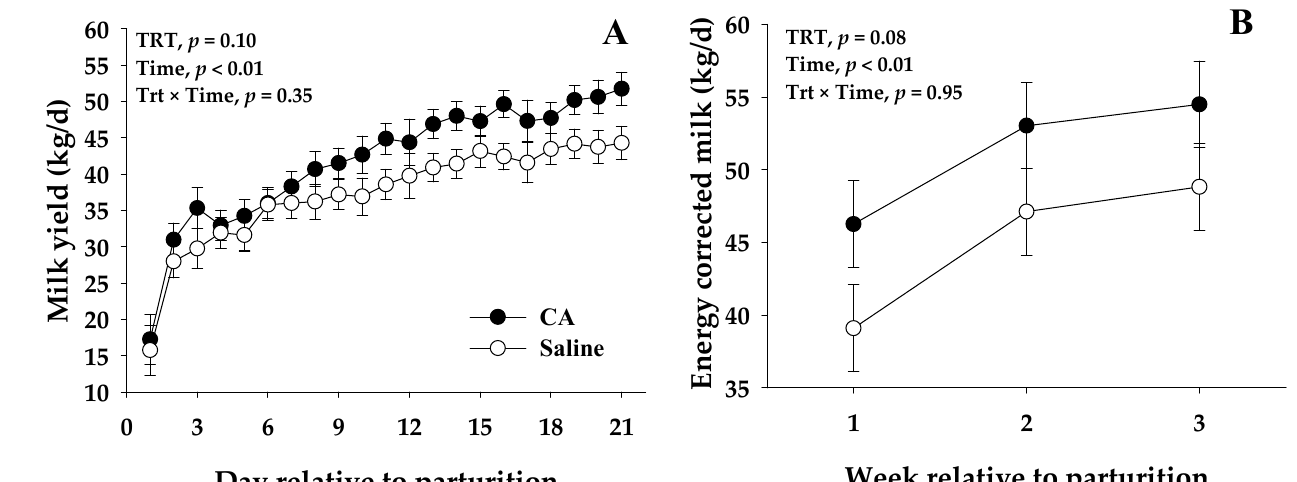
Figure 1. Milk yield ( A ) and energy corrected milk ( B ) for peripartal dairy cows infused from 1 to 3 d postpartum with 500 mL of sterile saline solution (Saline) or carnosic acid (CA) at a rate of 0.3 mg/kg BW supplied in a total volume of 500 mL of sterile saline solution. Values are means, and the standard errors are represented by vertical bars.